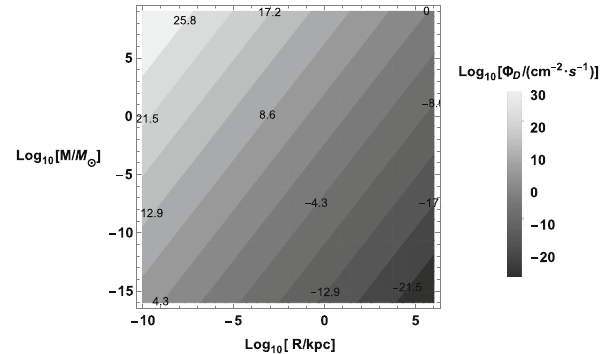
Fig. 3 The contour plot of the bound of total dark flux (cid:7) D in Eq. (4) with the Eddington luminosity and E D (cid:4) 3 . 5 keV, as a function of the distances R / kpc and masses M / M (cid:5) of black